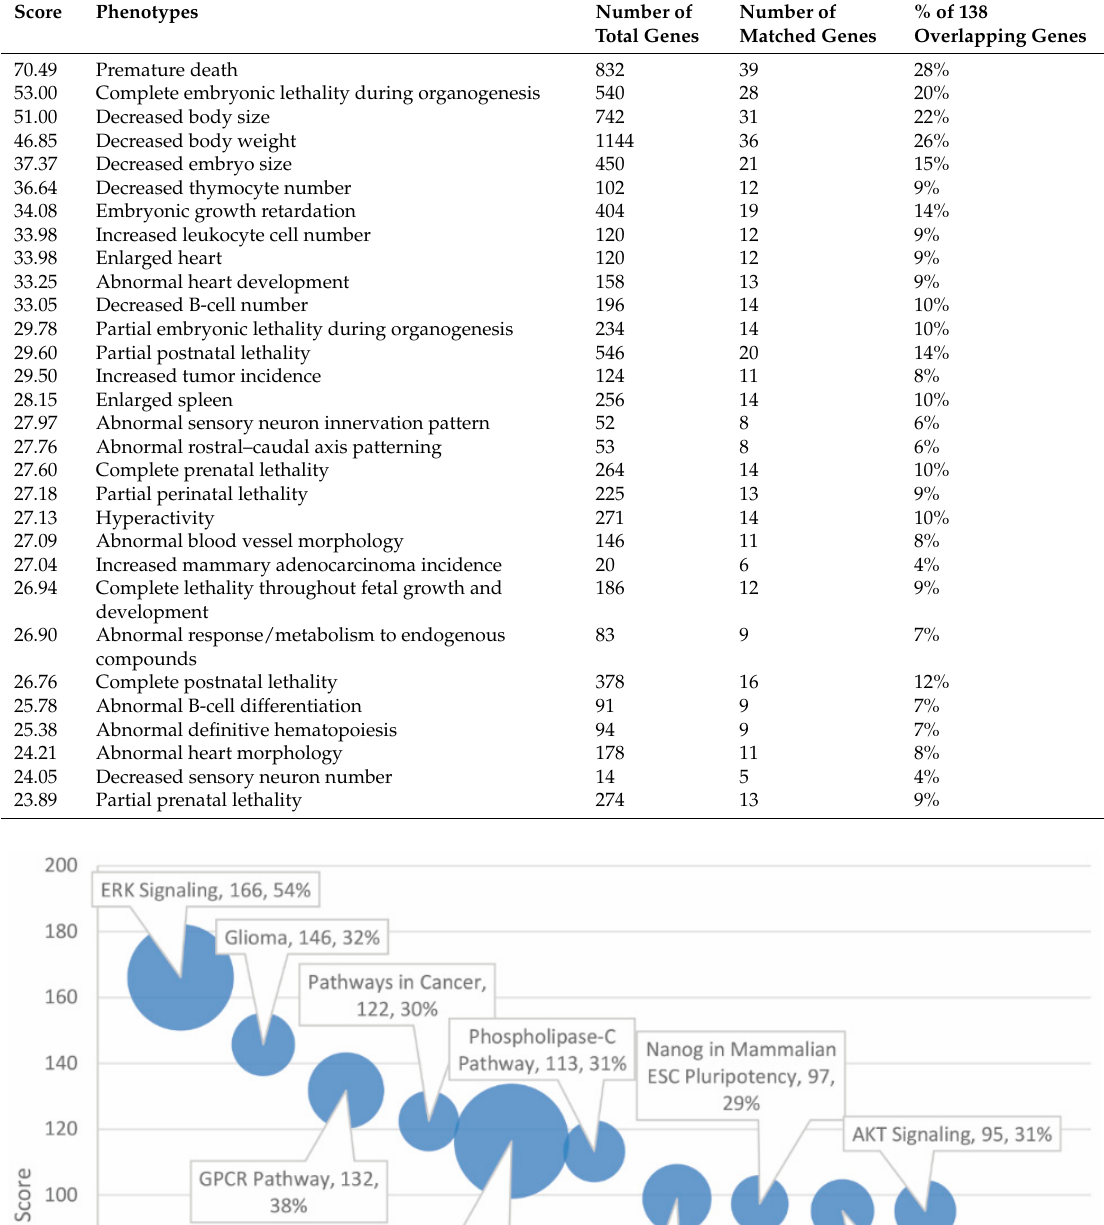
Table 5. Profiling of high scores in overlapping genes for autism and cancer-associated phenotypes.